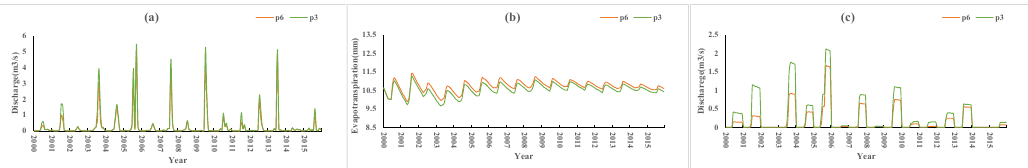
Figure 13. P6 vs. P3 simulation results: ( a ) surface runoff, ( b ) evapotranspiration, ( c ) farmland runoff.